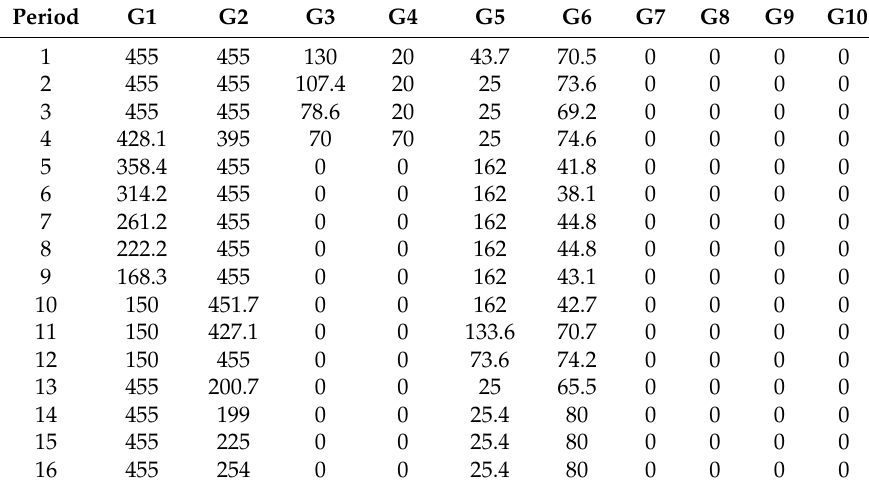
Table A6. Executed rolling plans for Case